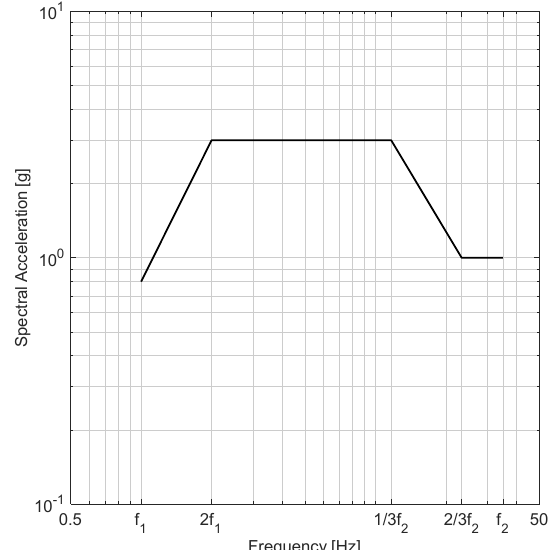
Figure 17. Response spectrum required according to IEC 60068 considering a frequency range from 1 (f 1 ) to 35 Hz (f 2 ), 5% damped.